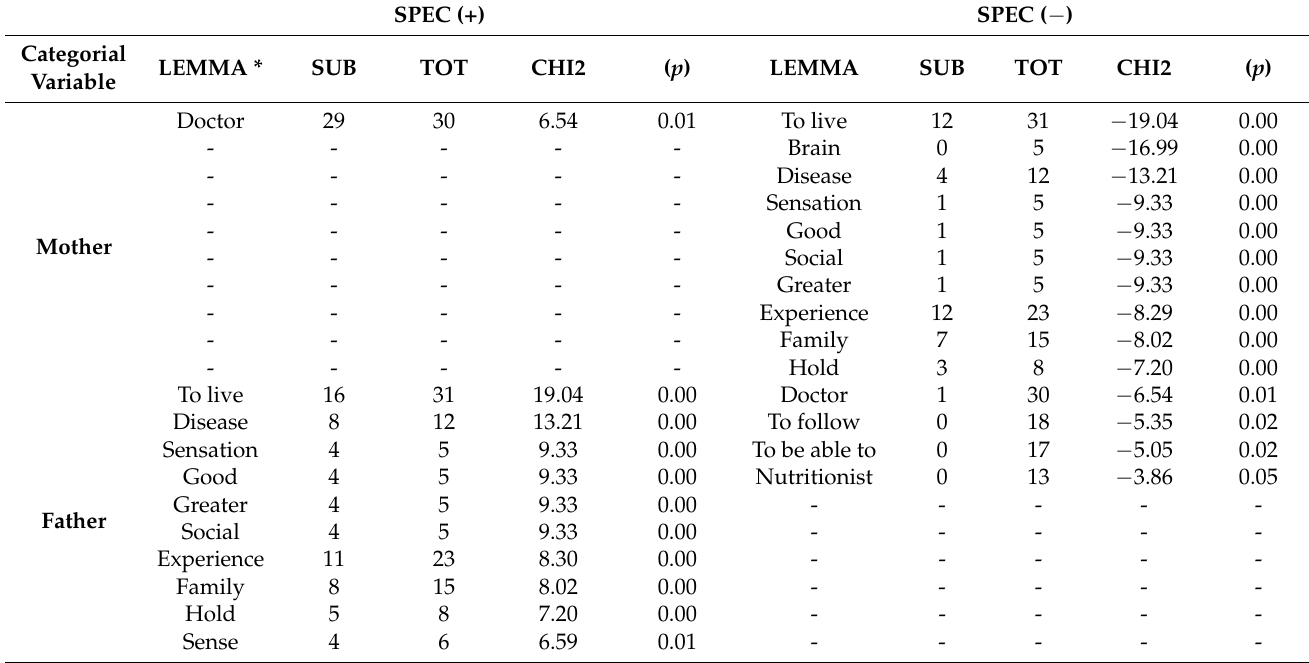
Table 5. Specificity in mothers and